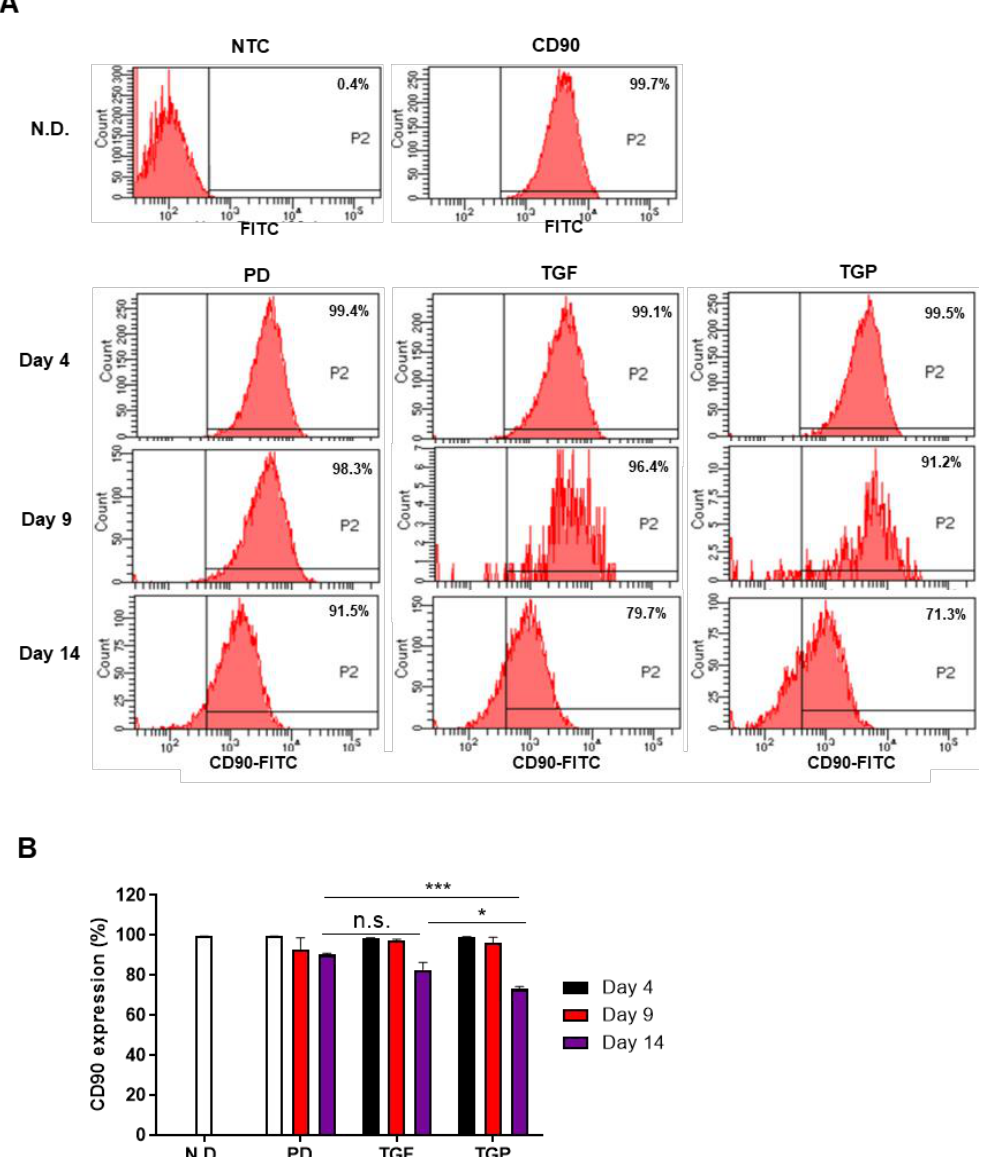
Figure 4. The expression of CD90 in SMCs differentiated from hUDSCs at days 4, 9, and 14 of differentiation. The expression of CD90 was analyzed by flow cytometry. ( A ) The values in the representative flow cytometry histograms indicate the percentages of CD90-expressing cells. ( B ) The percentage of CD90-expressing cells was analyzed from three independent experiments. Data are presented as mean ± SEM from three independent experiments. n.s.: no significance, * p < 0.05, *** p < 0.005. N.D.; undifferentiated, PD; PD98059, TGF; TGF-β1, TGP; PD98059 and TGF-β1.